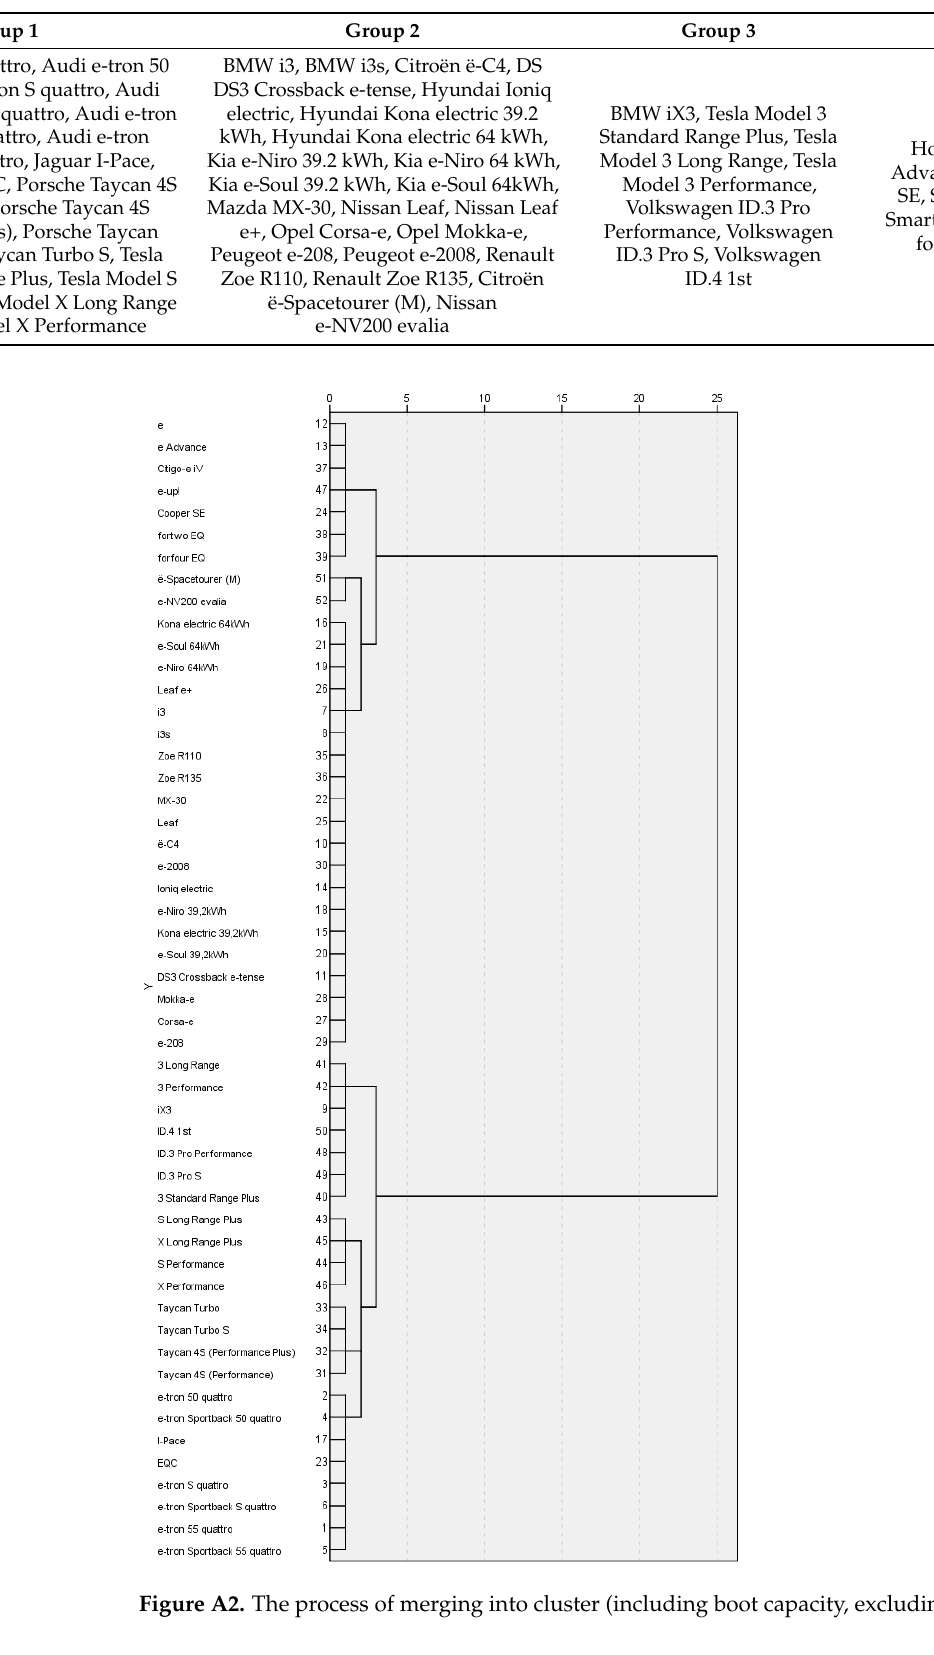
Table A1. List of cars assigned to particular groups.